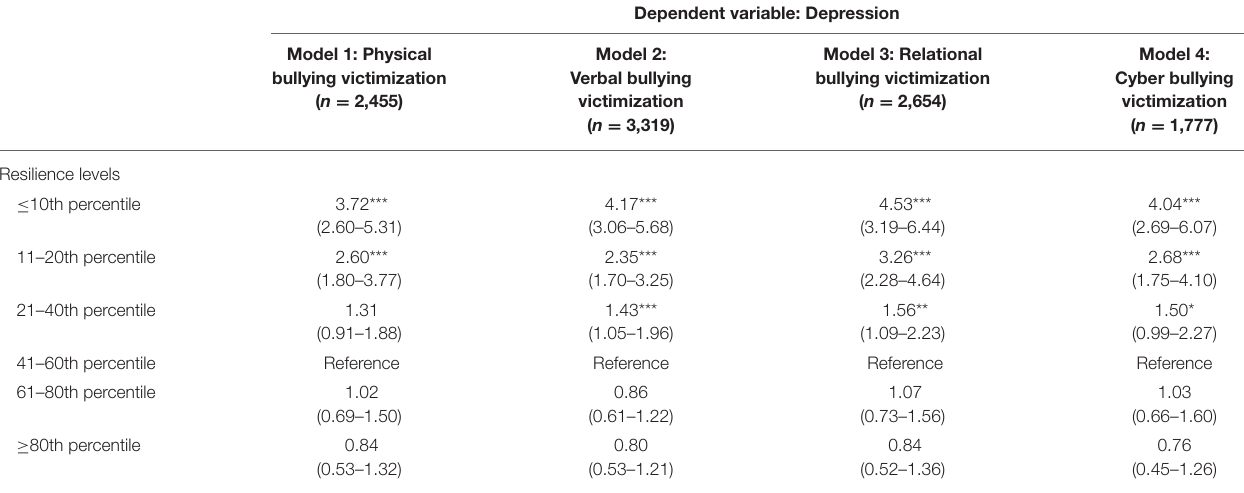
TABLE 3 | Odds ratio of depression stratified by resilience level and type of bullying victimization among victims of